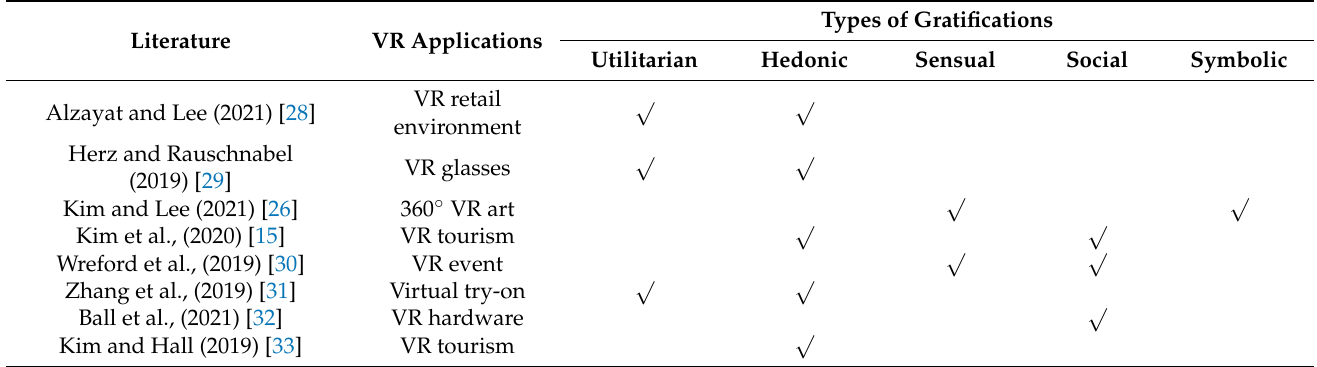
Table 1. Gratifications studied in previous VR